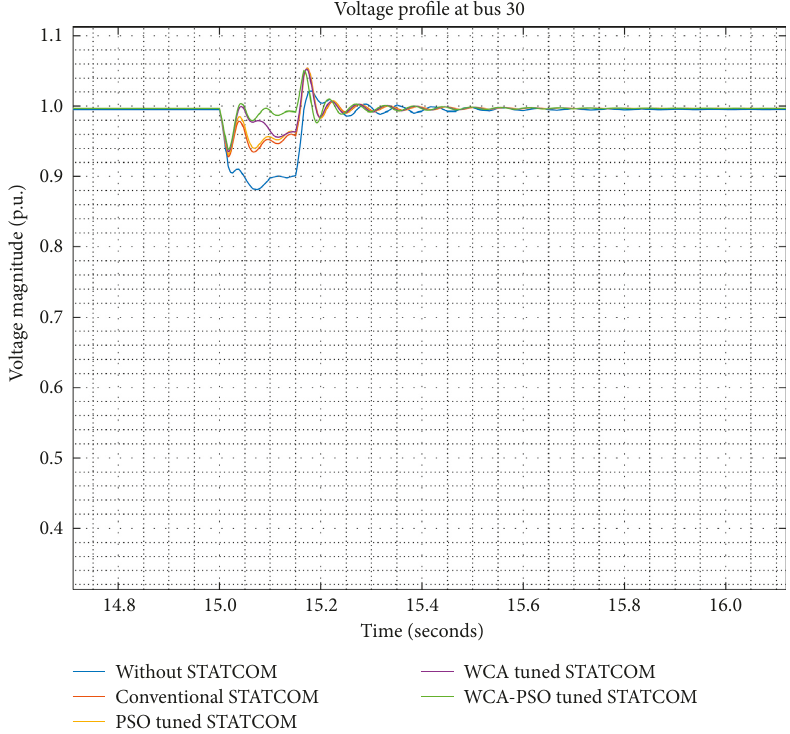
Figure 21: Voltage profile at WPP terminals.